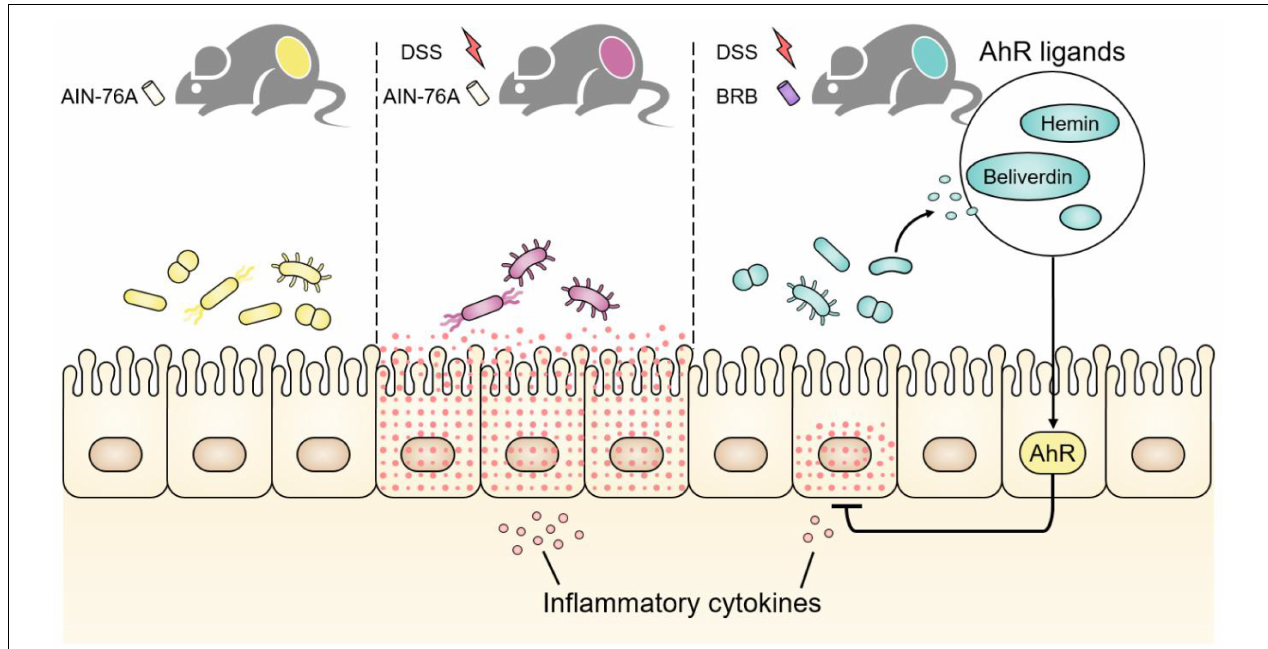
FIGURE 6 | Dextran sulfate sodium (DSS) treatment caused gut microbial disruption in addition to severe intestinal inflammation, which was ameliorated if mice were concurrently fed BRB diet. BRB dietary intervention increased intestinal AHR activity by modulating the gut microbiota and promoting production of microbiome-derived AHR ligands, for instance, hemin and biliverdin. Intestinal AHR activation contributed to alleviation of inflammatory response and restoration of host metabolic perturbation via diverse mechanisms including production of